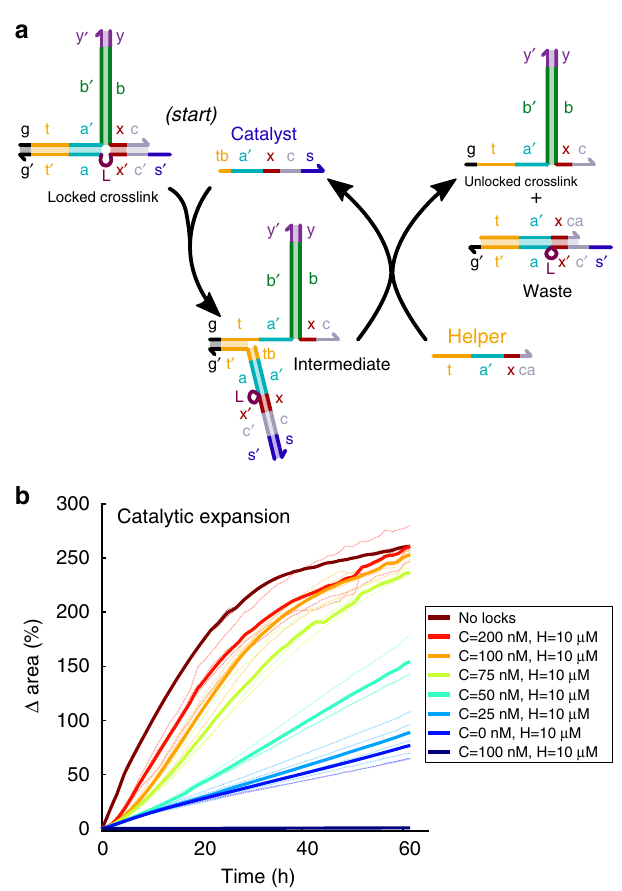
Fig. 4 Catalytic crosslink unlocking enables a signal at concentrations of 100 nM or less to trigger fast, high-degree swelling. a A Catalyst strand unlocks a crosslink via toehold-mediated strand-displacement to form an intermediate unlocked crosslink complex. A Helper strand reacts with this intermediate to release the Catalyst strand, allowing it to unlock another crosslink. b Expansion in response to different concentrations of Catalyst and 10 µ M Helper strands added to locked particles pre-incubated with DNA hairpins. Helper strands unlock crosslinks without Catalyst, but much more slowly than with Catalyst. Solid curves are the averages of measurements of 2 – 4 particles; dotted lines are the individual replicates for each